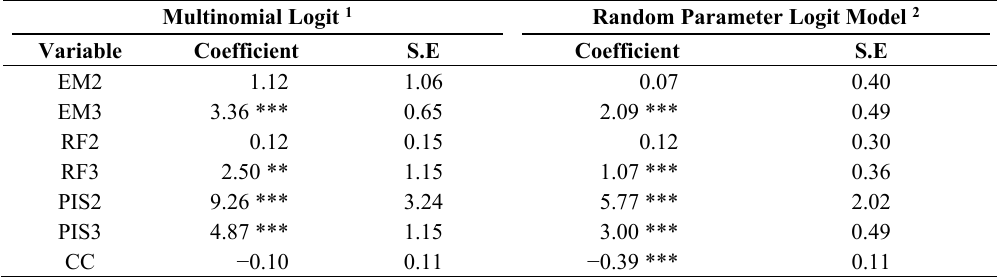
Table 5. Results of Simple MNL and RPL